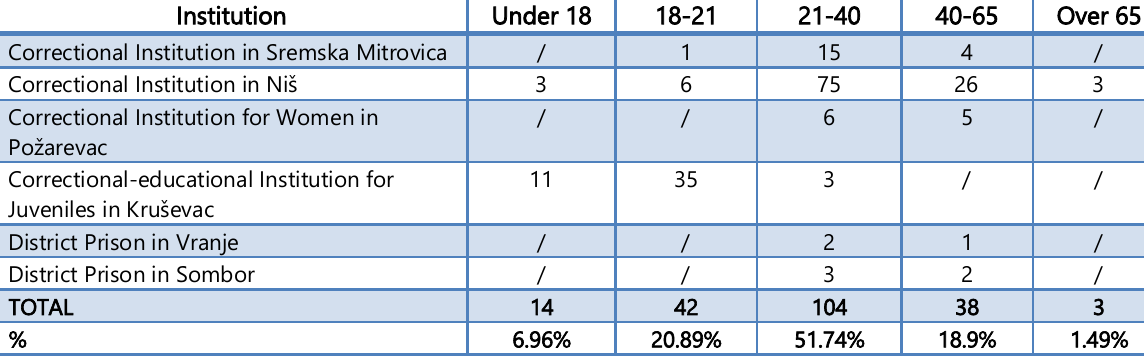
Table 2: Age of Interviewed Persons - Convicted Persons (Source: Author‟s depiction) Institution Under 18 Over